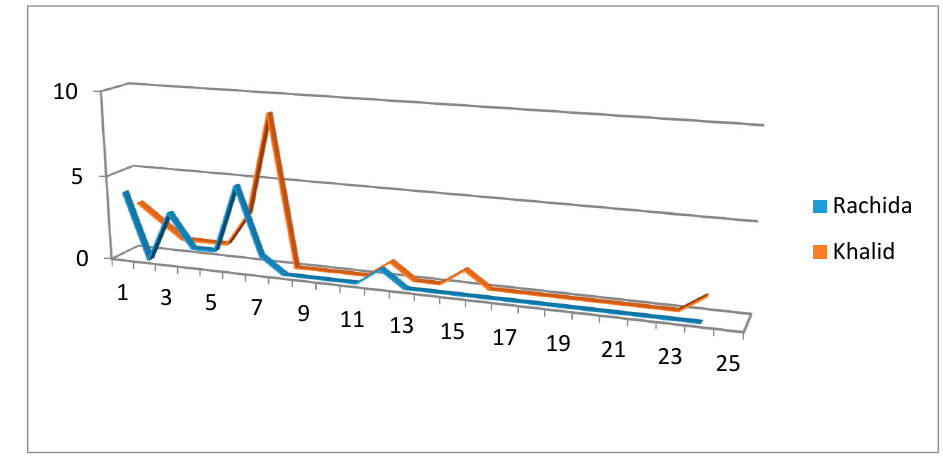
Figure 1. Number of occurrences of monosyllabic place holders (MPHs).The horizontal axis represents interview numbers; the vertical axis represents numbers of occurrences.